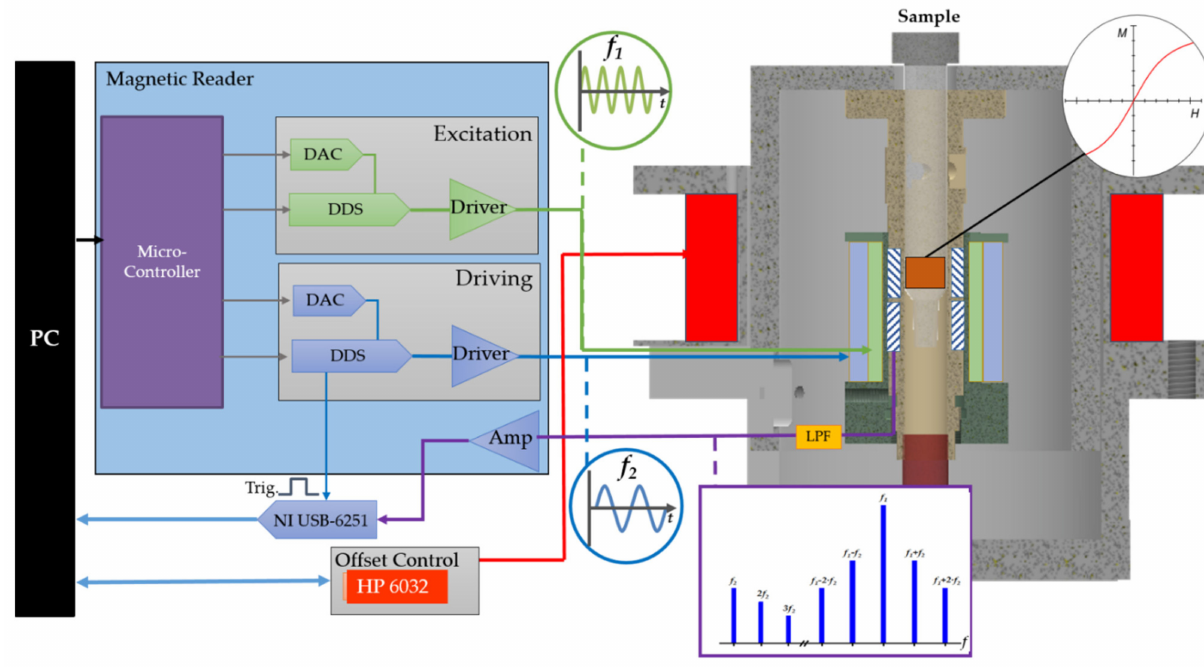
Figure 2. Schematic overview of the magnetic frequency mixing detection setup with the static magnetic offset field. A PC was used for controlling the magnetic reader and measurement. The magnetic reader consisted of a microcontroller, two direct digital synthesis (DDS) chips, and digital to analogue convertor (DAC) filters and drivers supplying the excitation and driver coils. A cutoff schematic of the measurement head is shown with excitation (green), driving coil (blue), and the static offset coil (red). The static offset coil was controlled by an HP 6032 power supply. The output of the detection coil, which contained the information about the mixing frequencies was connected via a low pass filter (LPF) to a preamplifier (Amp), which was built into the reader, and then to a National Instrument measurement card USB-6251 for a triggered